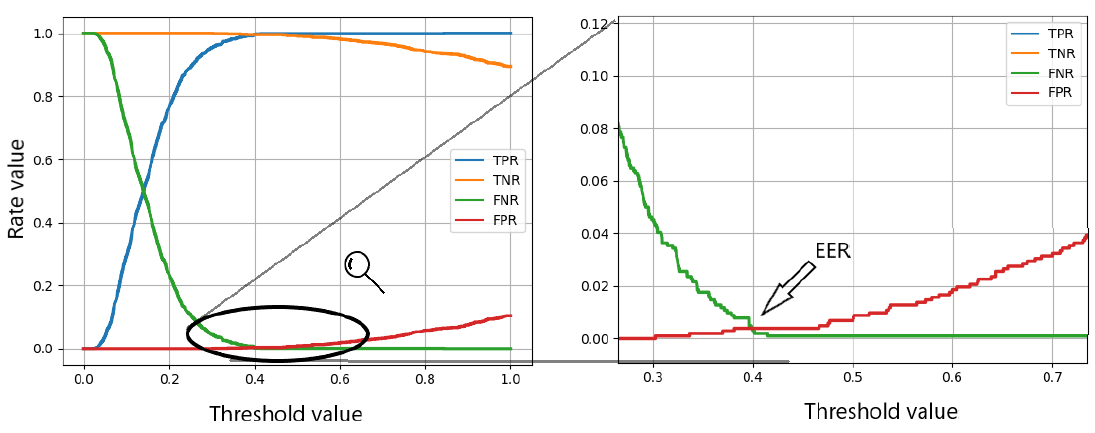
Figure 8. The influence of the threshold value on the True Positive Rate (TPR), True Negative Rate (TNR), False Negative Rate (FNR), and False Positive Rate (FPR) in the scanario of minimizing false